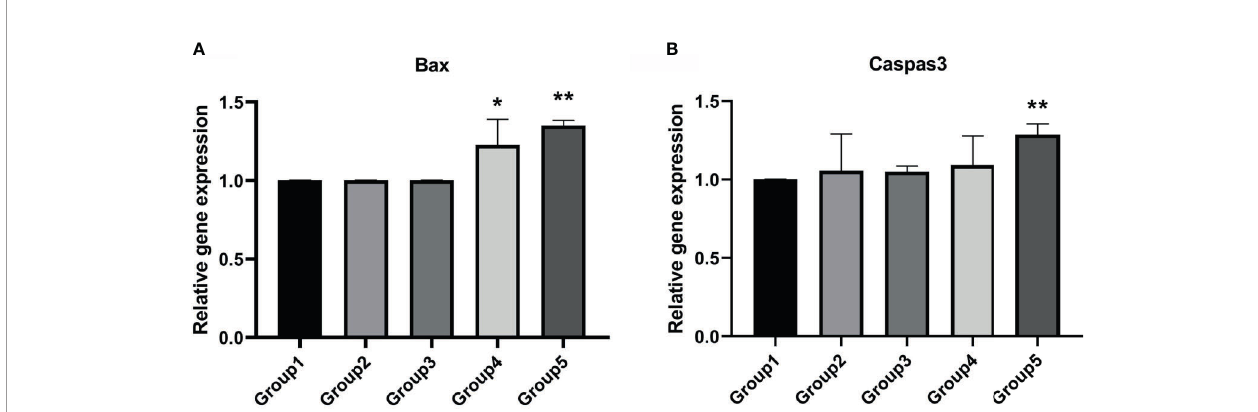
FIGURE 3 | Expression levels of apoptotic genes. (A) Group 4 and group 5 showed a signi fi cantly higher expression level of Bax . Values are shown as the mean ± the standard error of the mean (SEM). (B) Group 5 showed a signi fi cant higher expression level of Caspase3 . Signi fi cant difference, *P < 0.05, **P <